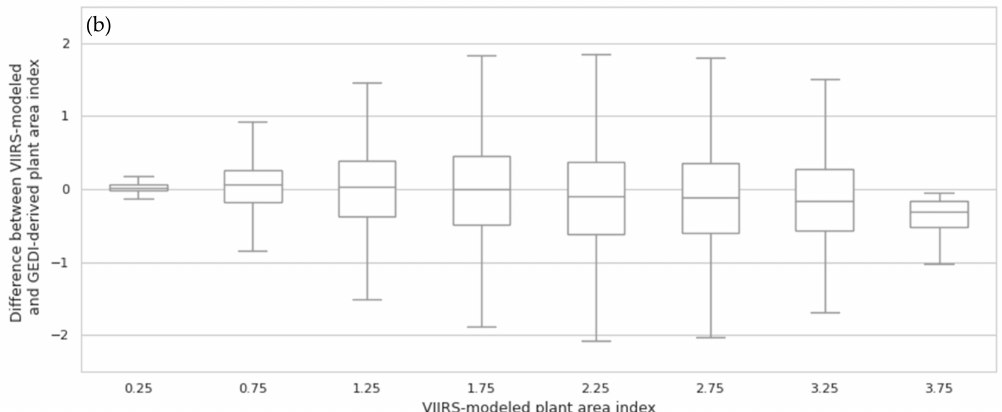
Figure 3. Distribution of differences between ( a ) VIIRS-modeled and GEDI-derived canopy height; and ( b ) VIIRS-modeled and GEDI-derived Plant Area Index.